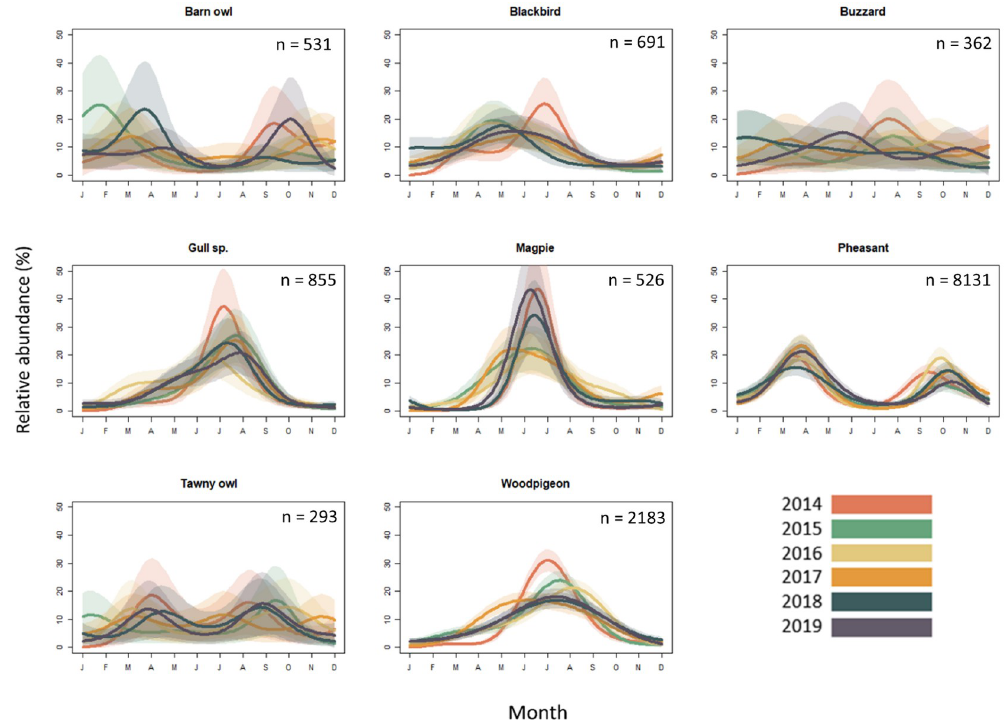
Fig 4. Seasonal variation in roadkill of birds. Abundance (monthly percentage of annual total for each taxon) of the most commonly reported roadkill wild birds in the UK. Records span 1 st January 2014 to 31 st December 2019. Shaded areas show 95% confidence